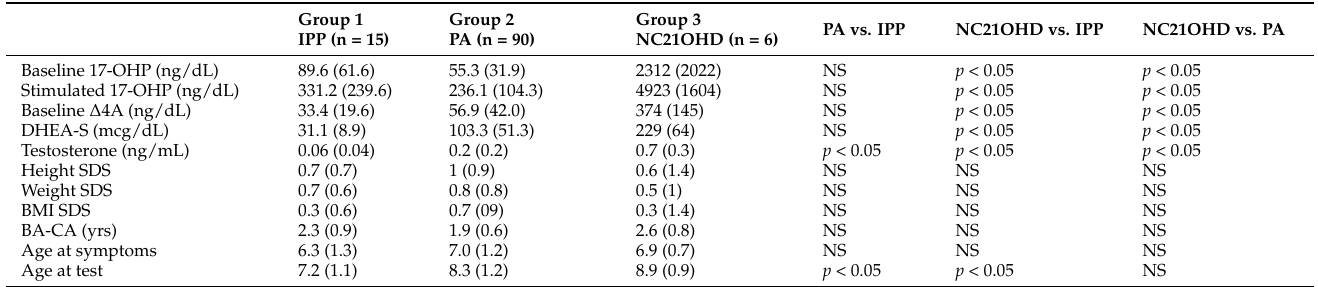
Table 2. Mean (SD) androgen levels, clinical features, and bone age advancement of patients subdi- vided by diagnosis. NS: Not Significant.